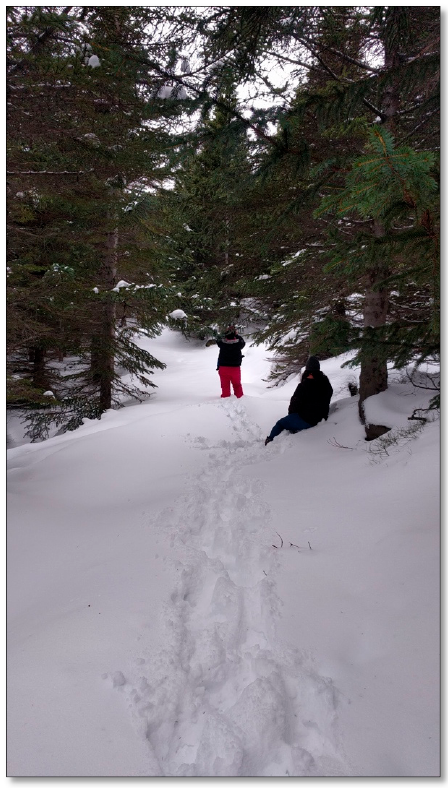
Figure 8. Tunguskógur forest. Figure 8. Tungusk ó gur